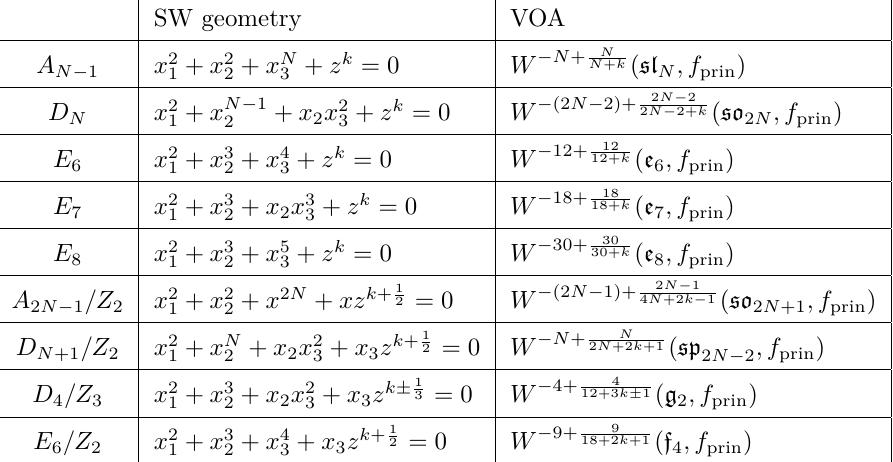
case! The corresponding 2